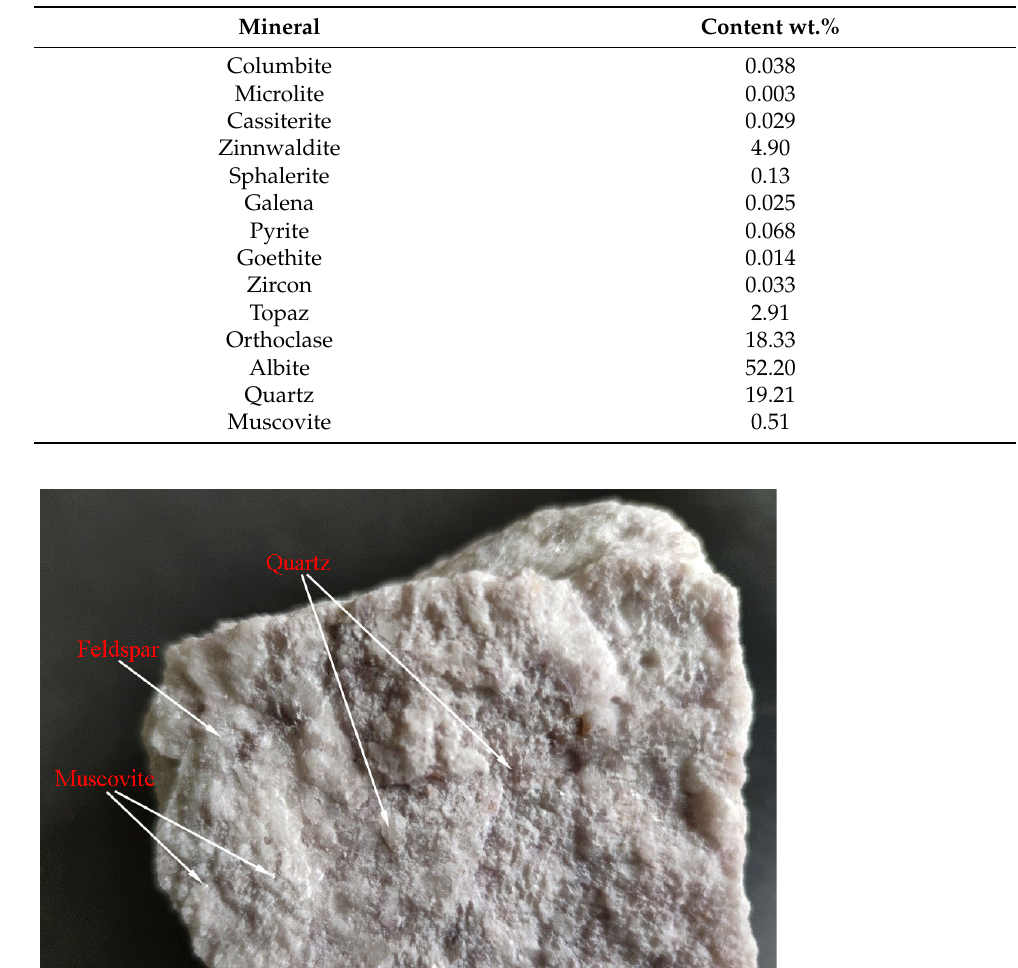
Table 2. Mineral composition and content of the ore.